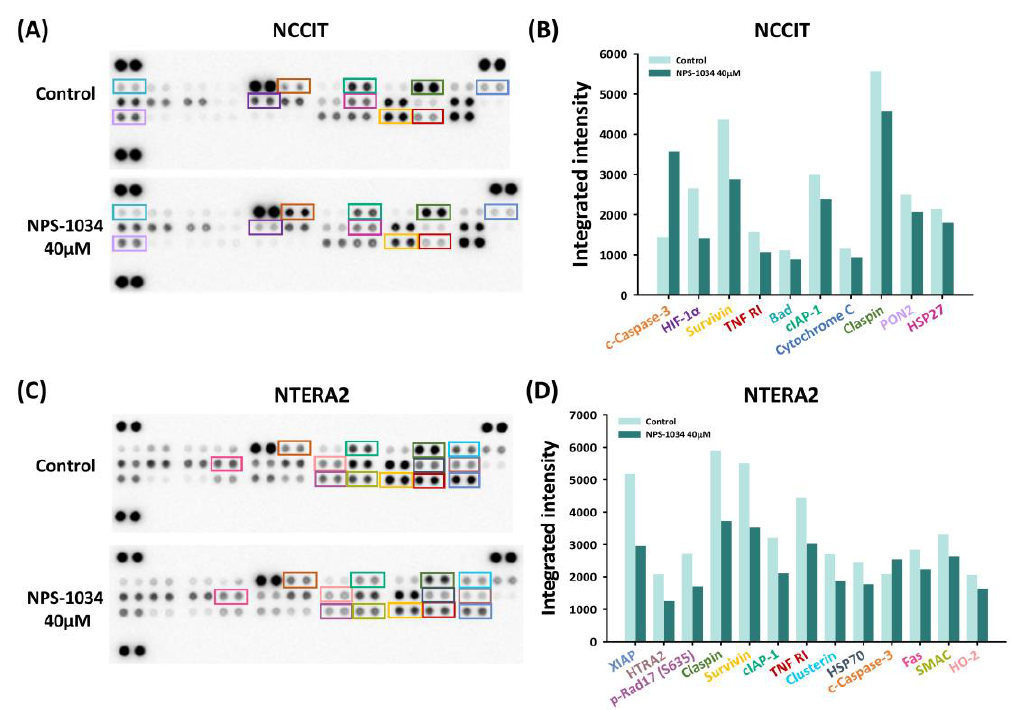
Figure 3. An apoptosis array examined the expressions of proteins involved in cell death caused by NPS-1034. Both ( A ) NCCIT and ( C ) NTERA2 cell lines were tested with an apoptosis array. The expressions of proteins were quantified into bar charts, as shown in ( B ) and ( D ). The proteins were aligned based on the extent of changes in the protein expressions before and after NPS-1034 treatment.